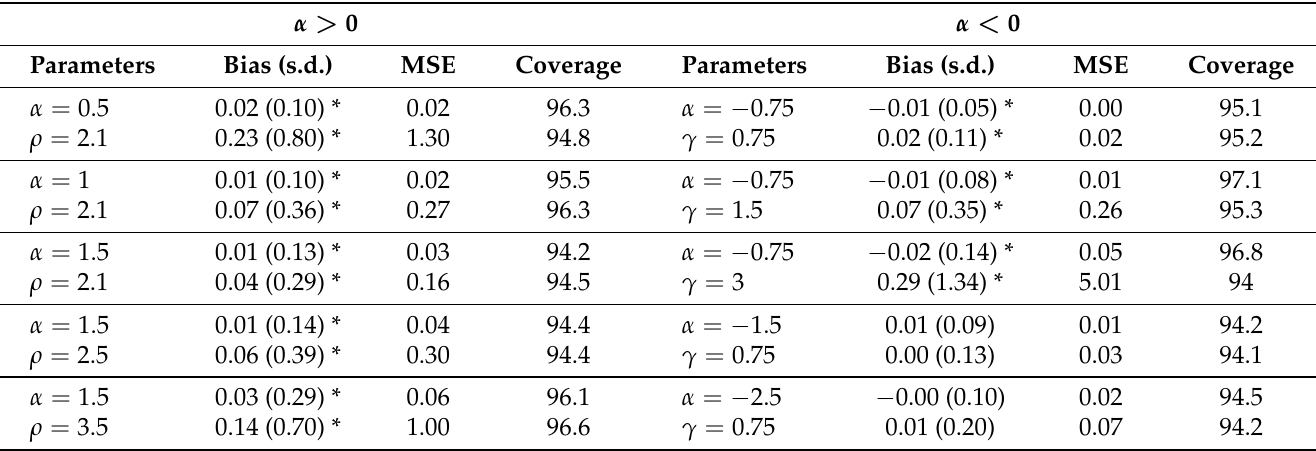
Table 3. Mean bias and s.d. in brackets (* indicates a statistically significant bias at 5% level), average mean square error (MSE) and coverage for EBW